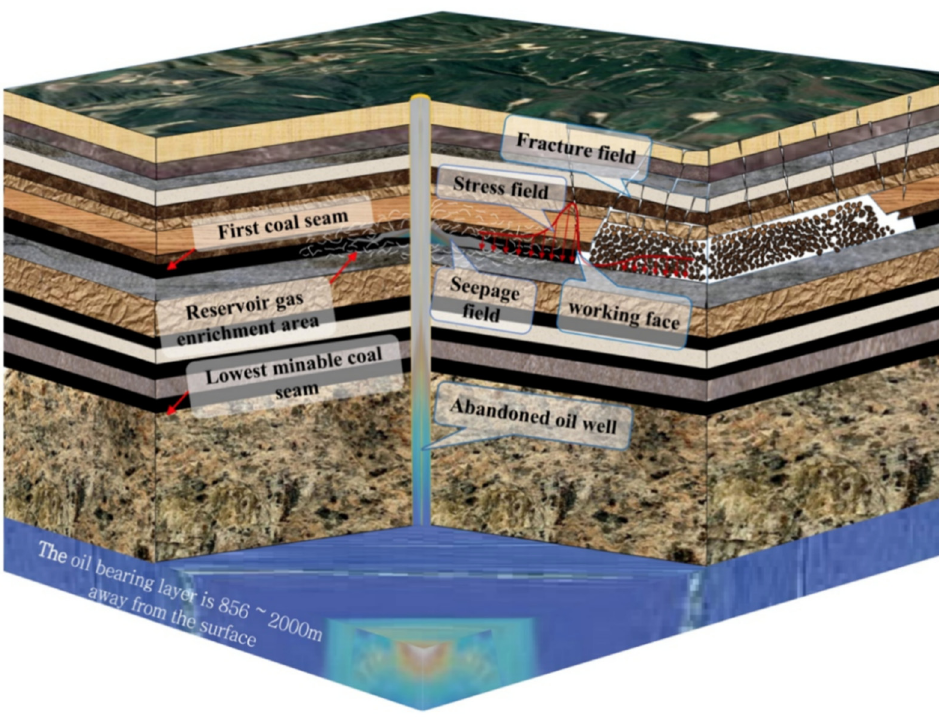
Figure 1. Oil and gas disasters in coal and oil resources co-storage areas.